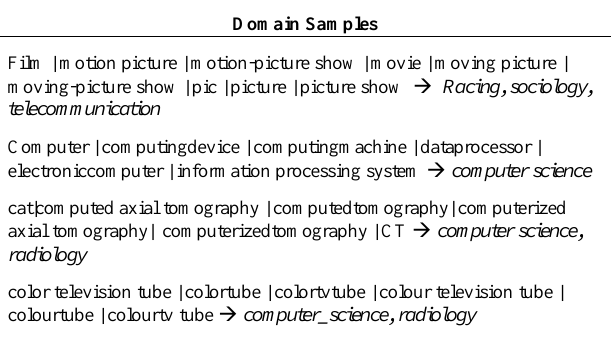
Table 1. Sample labels for synsets in Domain WordNet. Domain